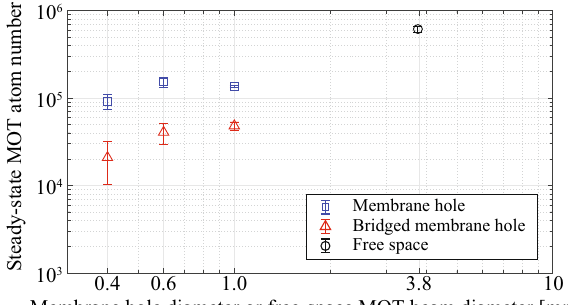
Figure 3. Steady-state MOT atom number versus membrane hole diameter ( d hole ) or free-space MOT beam diameter ( d MOT ). The d MOT comes from the 1 / e 2 Gaussian beam diameter and the d hole comes from the etched hole diameter of the membrane MOT devices. The six-beam MOTs were generated by cooling beams, i.e. MOT beams, and a repump beam in Cs atoms (852 nm, D2 transition). Steady-state MOT atom numbers were measured in the free space (black circle), the membrane hole (blue square), and the bridged membrane hole (red triangle) using an absorption probe (895 nm, D1 transition). We used a 3.8 mm beam diameter ( d MOT ) for the free-space MOT and 0.4, 0.6, 1.0 mm diameter membrane holes ( d Hole ) for the membrane MOT and the bridged membrane MOT. The bridged membrane MOT experimentally simulates the situation of a 3- µ m-width membrane ridge waveguide across the membrane hole.